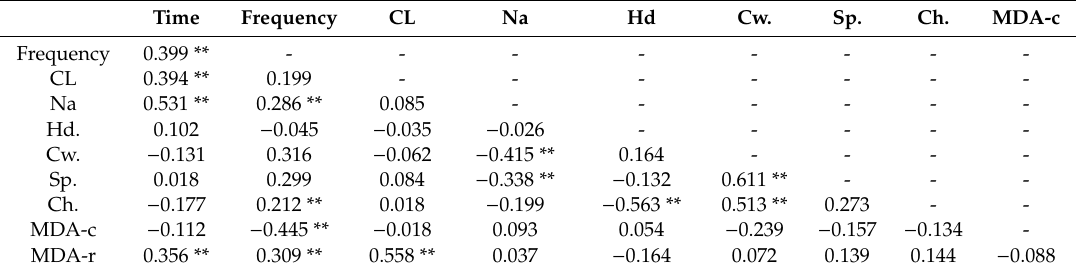
a Frequency used; treatment time (time); cooking losses (CL); sodium content (Na); hardness (Hd); chewiness (Cw); springiness (Sp.); cohesiveness (Ch), malondialdehyde (MDA) ( µ g / g of meat) cooked sample (MDA-c) and MDA on raw sample (MDA-r). Values are significant at ** p < 0.001.